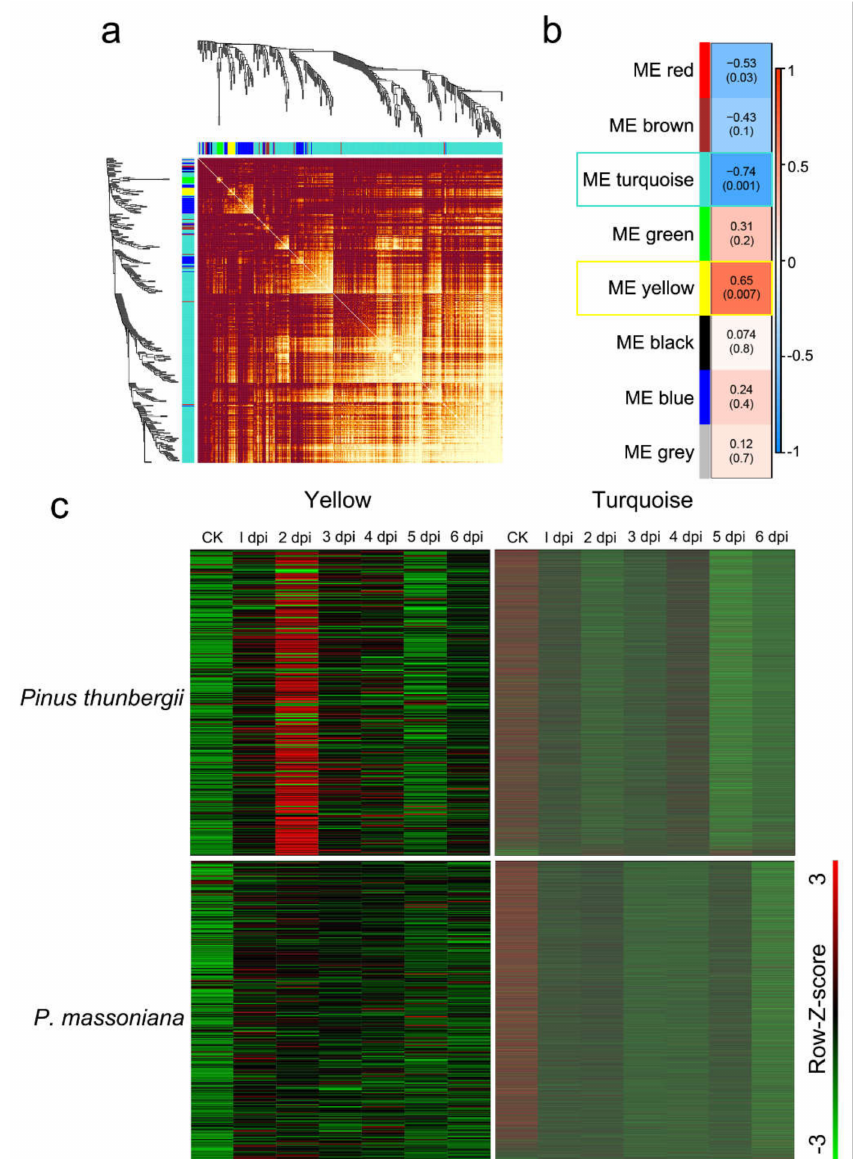
Figure 3. WGCNA revealed modules closely related to the nematode population after inocula- tion. ( a ) Visualizing the gene network using a heatmap plot (400 genes were randomly selected). The heatmap depicts the topological overlap matrix among all genes in the analysis. Dark red color represents low overlap and progressively brighter color represents higher overlap. Blocks of brighter colors along the diagonal are the modules. The gene dendrogram and module assignment are also shown along the left side and the top. ( b ) Associations for module eigengene and nematode population. Each cell contains the corresponding correlation and p value. The table is color coded by correlation according to the color legend. ( c ) Heatmap of module gene expression (rows) across the samples (columns) for yellow and turquoise